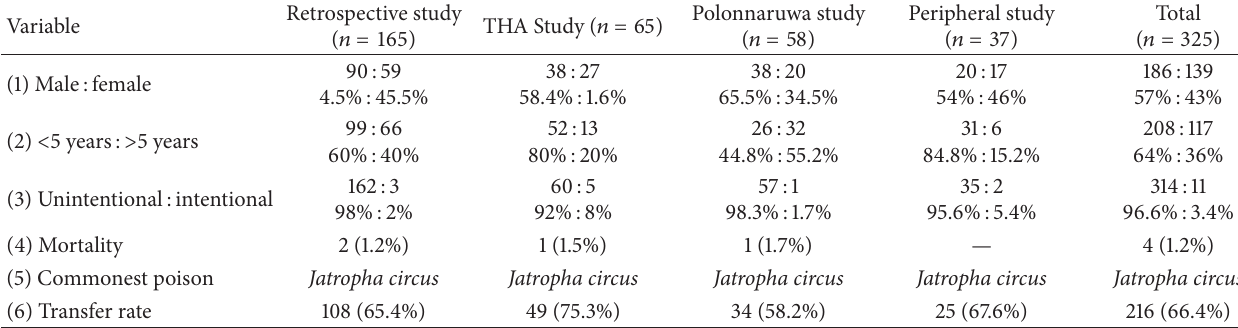
Table 1: Demographic characteristics, patterns of poisoning, and transfer rates of children with plant poisoning.